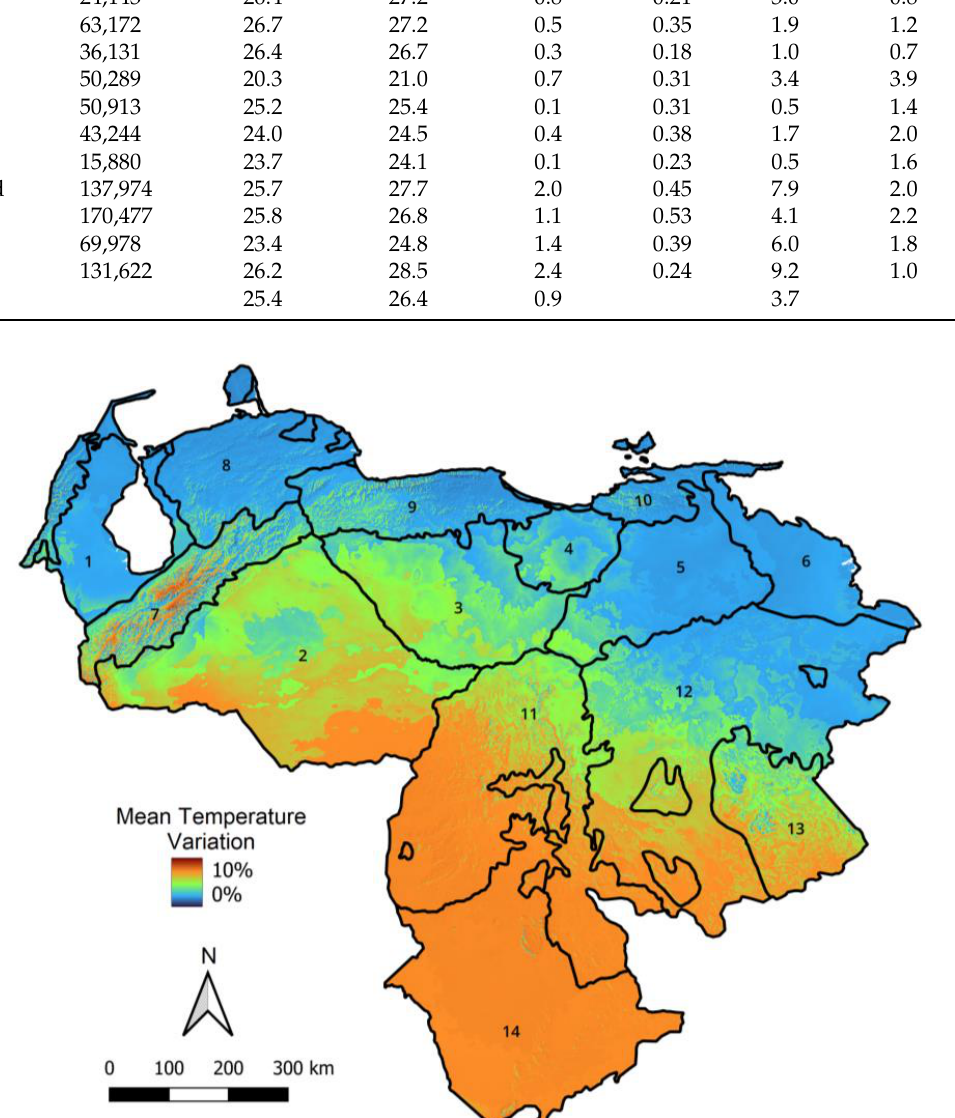
Figure 3. Map of percent of variation of the mean annual temperature between 1970–2000 and 2041–2060 in Venezuela, with the boundaries of the physiographic regions numbered as in Table 1.